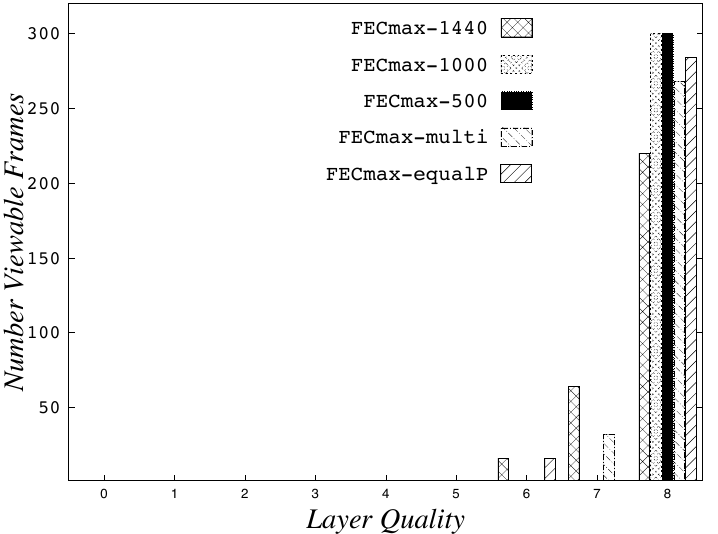
Figure A21. Example of the number of viewable layers for SVC-SC, for each of the FEC max Packet thres , at a packet loss rate of 10% and a GOP of 16. This image illustrates an increase in the FEC max for C1 and C2 based on the worst case scenario, as shown in Table